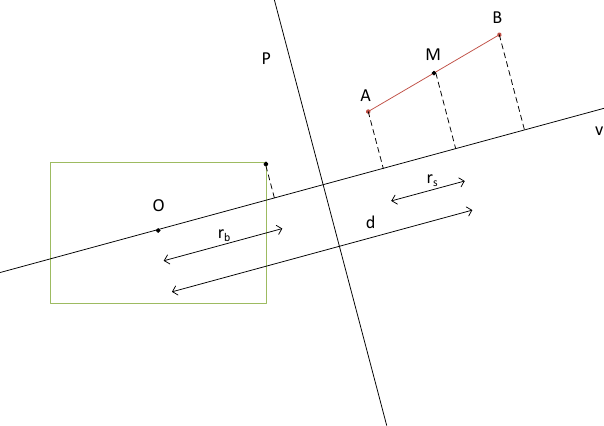
Figure 6. Diagram of the Intersection Detection of a Line Segment and an OBB.